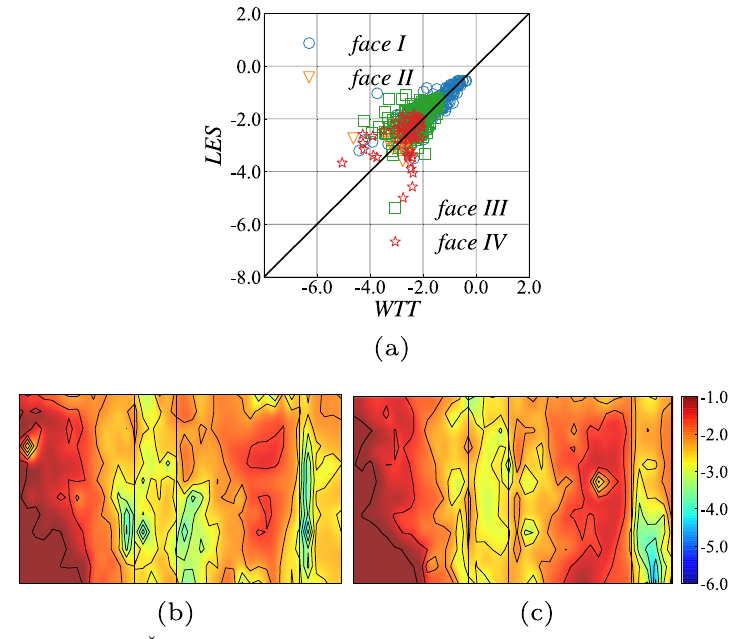
Fig. 7 The peak values of ˇ C p from all the degrees: ( a ) scatter plots, ( b ) surface distribution of WTT and ( c ) surface distribution of